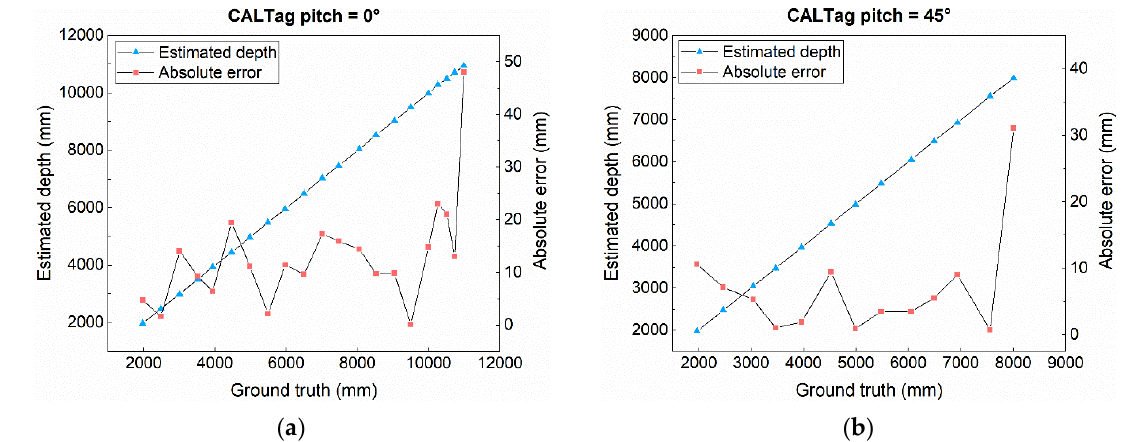
Figure 6. Maximum detectable depth under pitch difference. ( a ) Estimated depth under CALTag pitch = 0°. ( b ) Estimated depth under CALTag pitch = 45°.